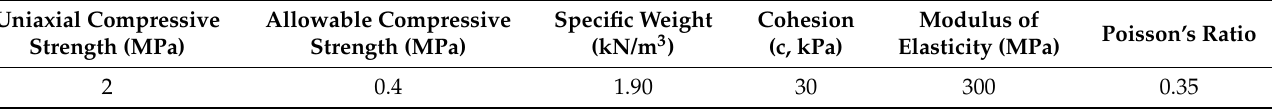
Table 4. Physical properties of the DCM composite column